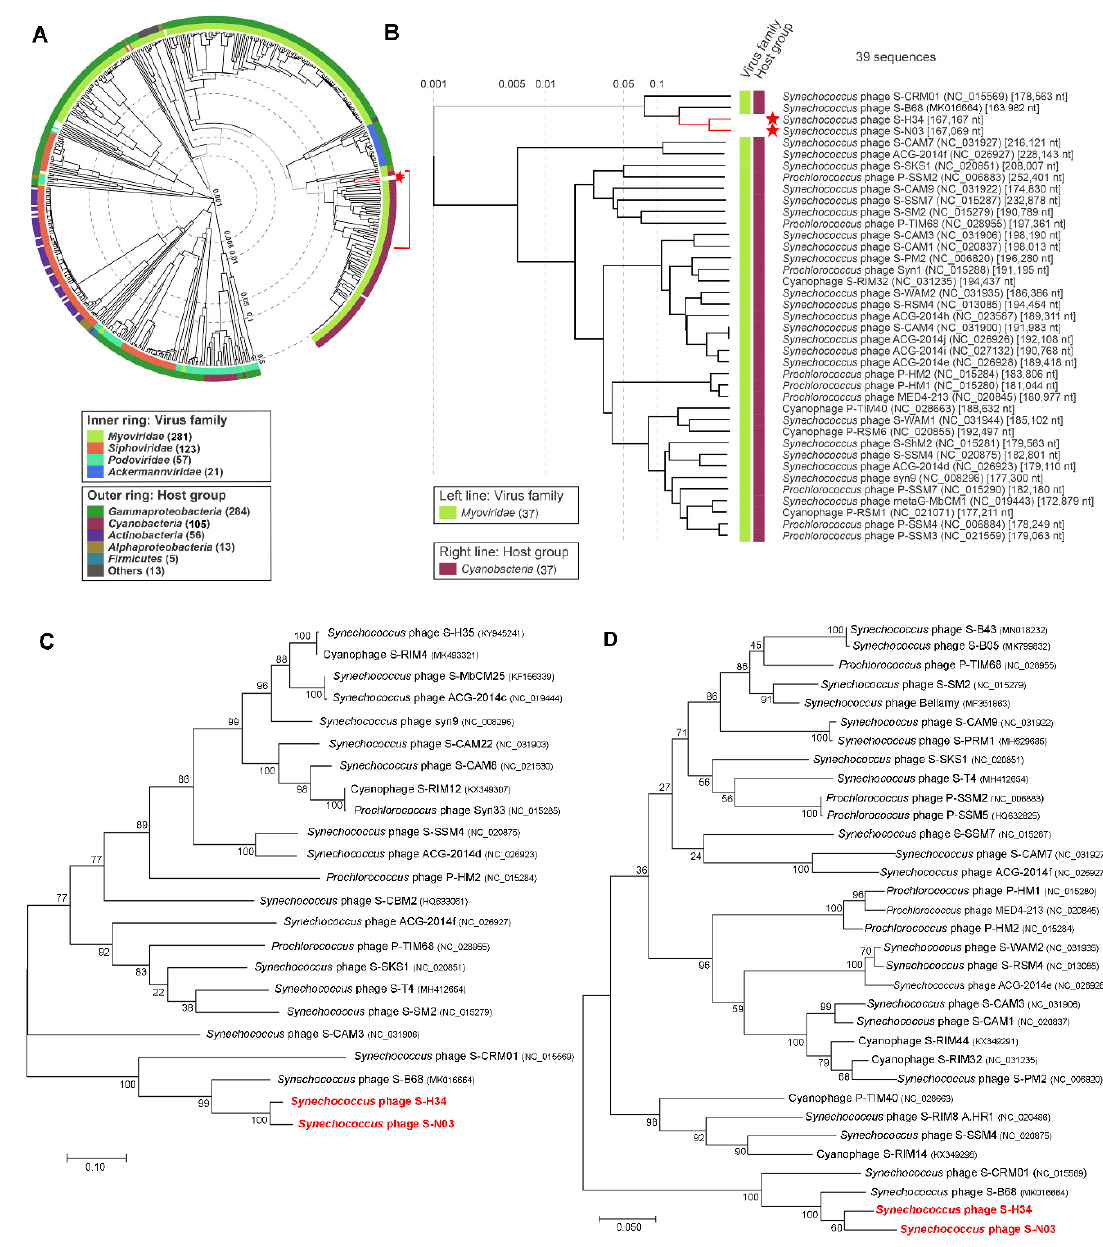
Figure 2. Phylogenetic analysis. ( A , B ) Phylogenetic analysis with other related phages using the genome-wide sequence similarities computed by tBLASTx. These evolutionary trees have no roots. ( C , D ) Phylogenetic ML tree with other related phages based on the amino acid sequences of ( C ) DNA polymerase and ( D ) terminase large subunit. The trees were constructed in MEGA version 7 by the ML method with 1000 bootstrap replicates. The percentage of replicate trees in which the associated taxa clustered together in the bootstrap test are shown next to the branches. The scale bar represents 0.1 ( C ) or 0.05 ( D ) amino acid substitution per site.